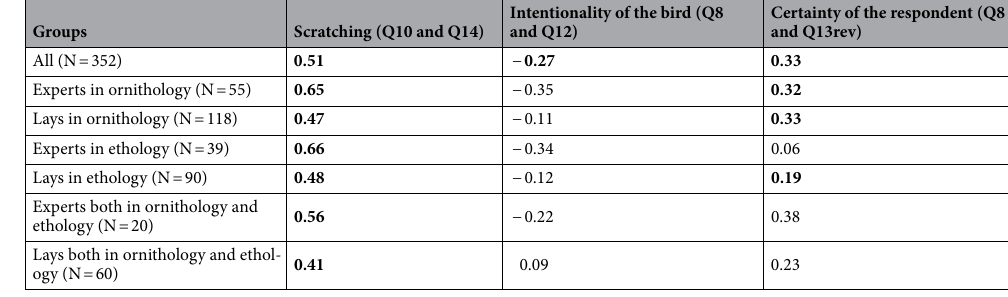
Table 2. The results of the Cohen’s kappa reliability analyses for the three pairs of questions within different groups of experience ( all —all respondents, expert— “professional” answer to Q19 and/or Q20 ; lay— “no experience” answer to Q19 and/or Q20 ). Statistically significant values ( p < 0.05) are highlighted in